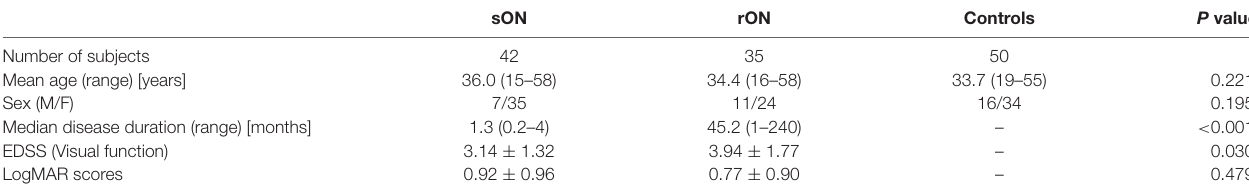
TABLE 1 | Descriptive data of the study